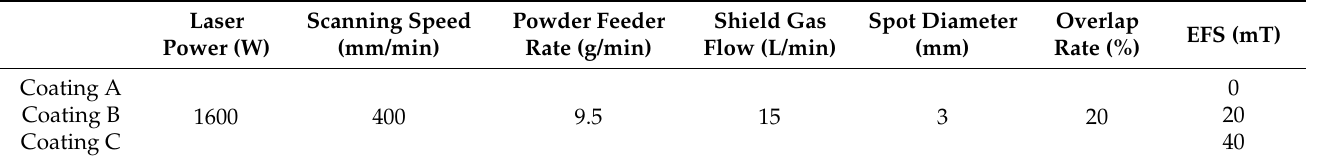
Table 4. Processing parameters for LC.